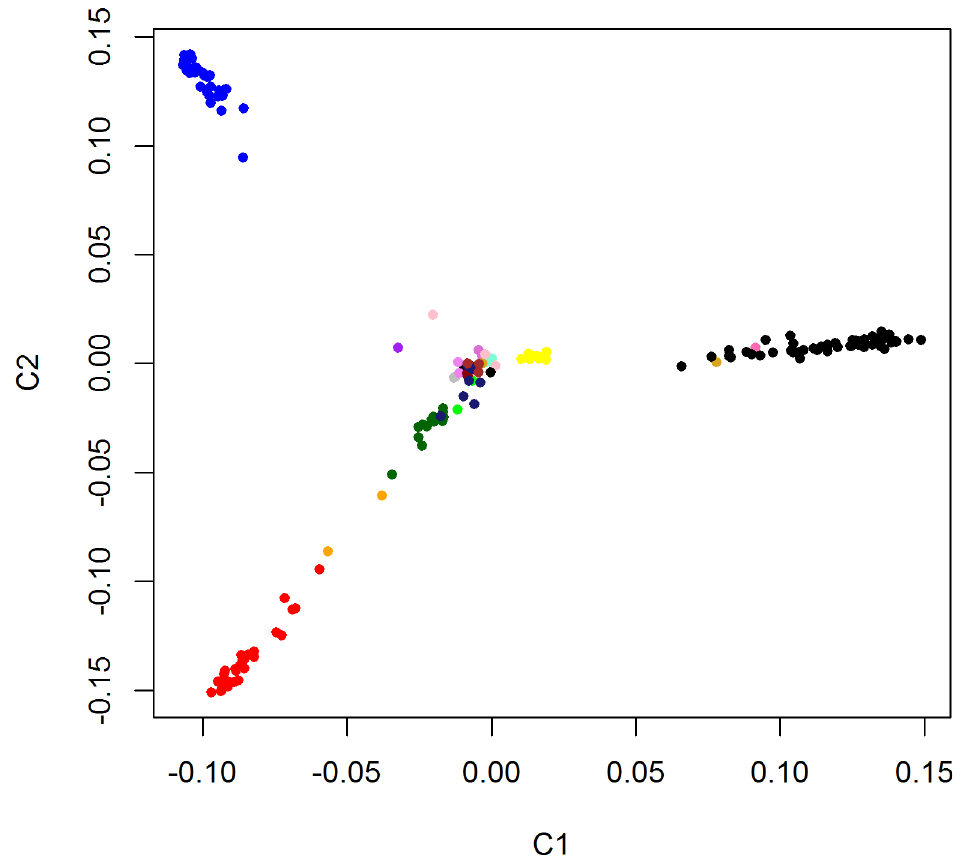
Fig 1. Principal component analysis (PCA) showing the genetic relationship between the sampled breeds and the grouping of the first two main components (C1 and C2) in three homogeneous sets and three heterogeneous sets. Labrador Retriever (black), Italian Greyhound (goldenrod), Cocker Spaniel (pink), Rottweiler (blue), German Shepherd Dog (forest green), Belgian Shepherd Dog (red), White Swiss Shepherd Dog (orange), and Golden Retriever